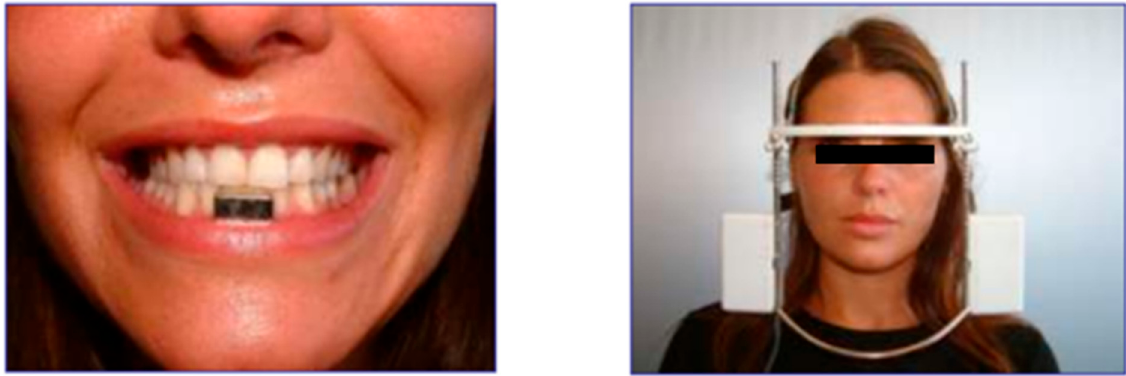
Figure 1. Kinesiography recording. A magnet was placed on the buccal surface of the lower incisors, and therefore a helmet with the sensors was positioned on the head of the subject with the help of a ruler.